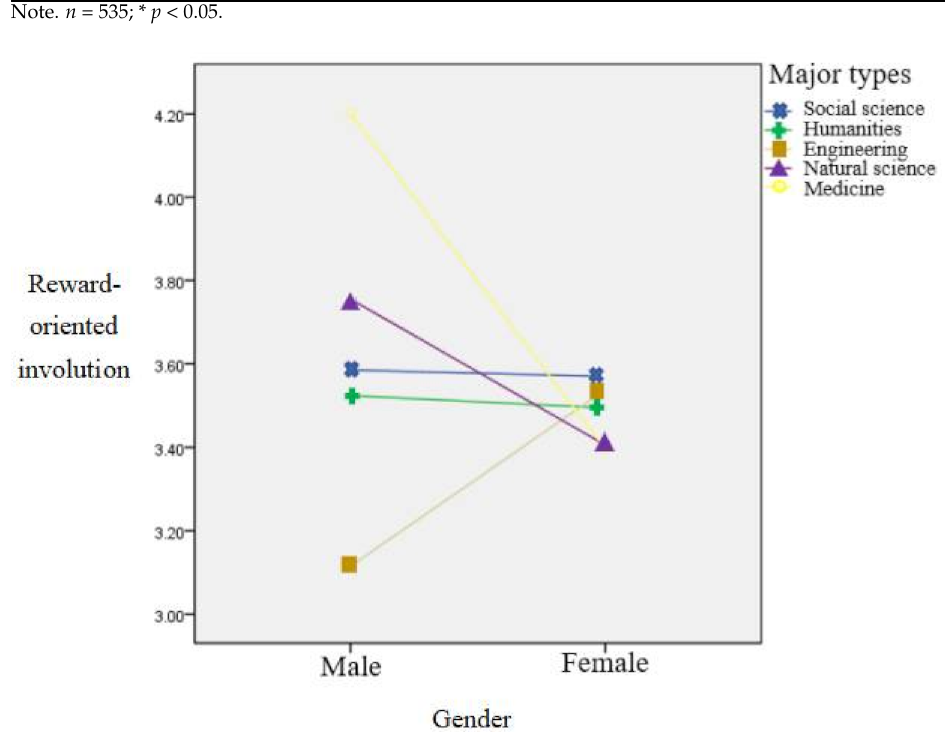
Figure 3. Interaction diagram of gender and academic background for reward-oriented involution. n =